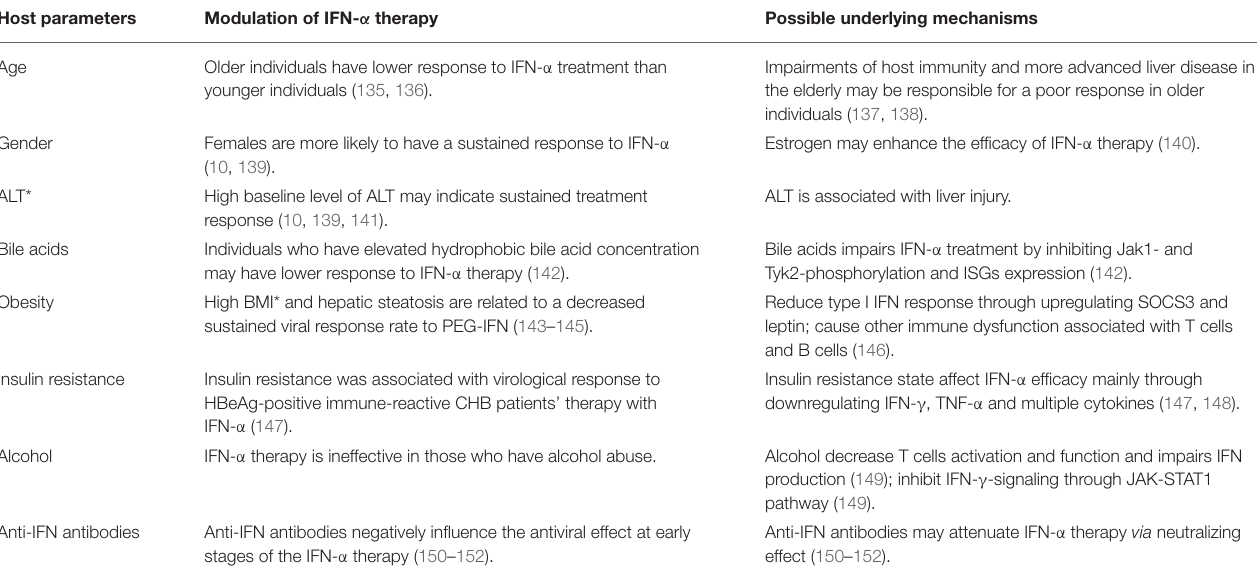
TABLE 2 | Involvement of host parameters in reflecting the IFN- α therapy efficacy in CHB patients. Host